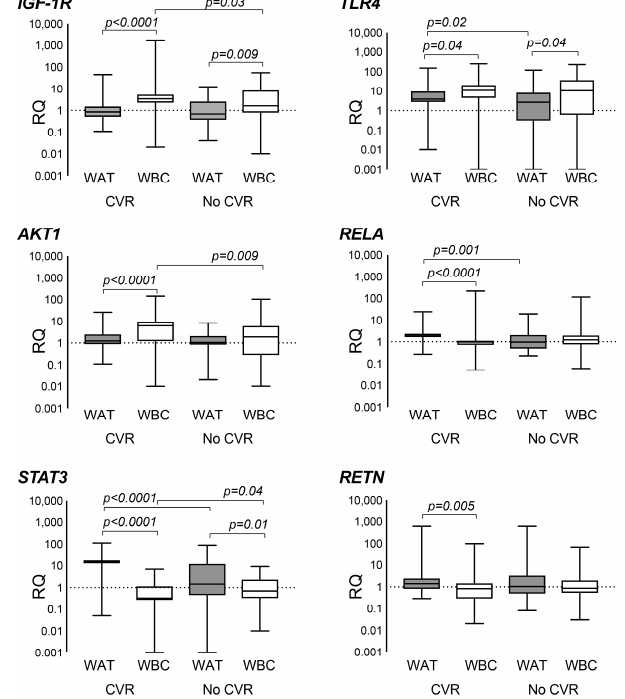
Figure 3. Gene expression analysis in leukocytes and in subcutaneous adipose tissue of patients with rheumatoid arthritis different in cardiovascular risk. Gene expression analysis was done in leukocytes of the peripheral blood (WBC, n = 95) and in subcutaneous adipose tissue (WAT, n = 83) of female RA patients by real-time PCR. Relative quantity (RQ) of expression for each gene was calculated in relation to the reference group that consisted of 11 young (mean age 38.4 years) non-smoking methotrexate-treated female RA patients with normal weight and their disease in remission. Statistical comparison between the group pairs was done with the nonparametric Mann-Whitney U test. The boxes represent medians, Q1–Q3; whiskers show min-max range. IGF-1R , insulin-like growth factor 1 receptor; AKT1 , serine-threonine kinase 1; STAT3 , signal transducer and activator of transcription 3; TLR4 , Toll-like receptor 4; RELA , transcription factor p65; RETN ,